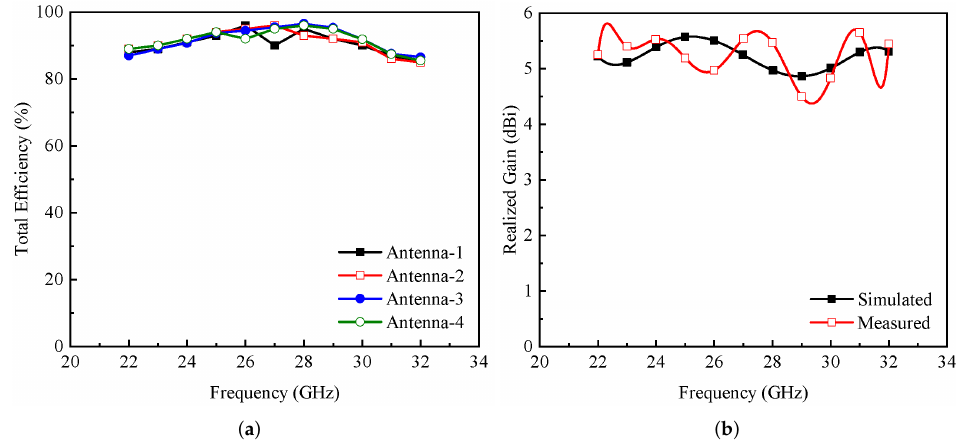
Figure 9. ( a ) Total efficiency and ( b ) realized gain of the proposed MIMO